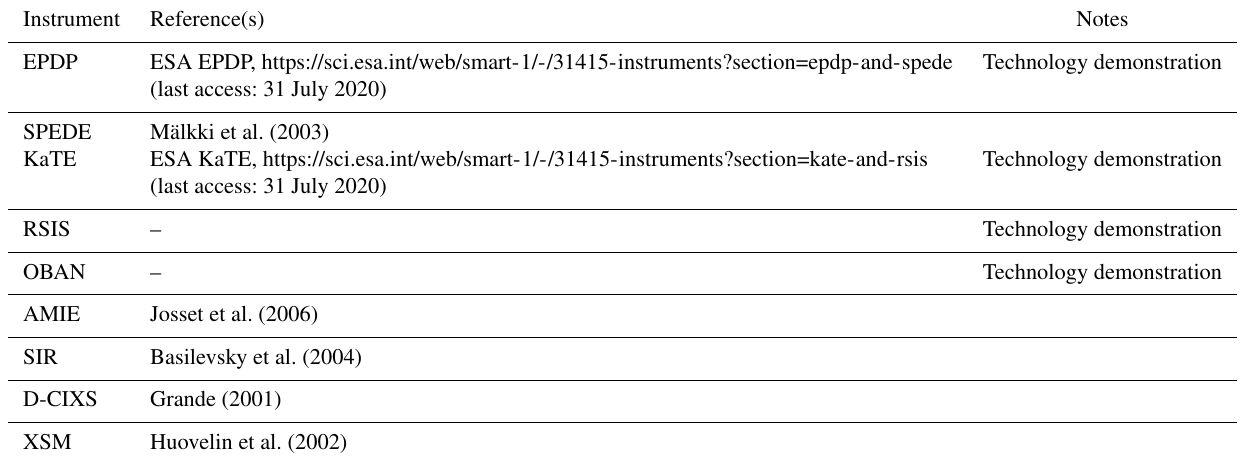
Table A5. SMART-1’s instruments and references for team members lists.